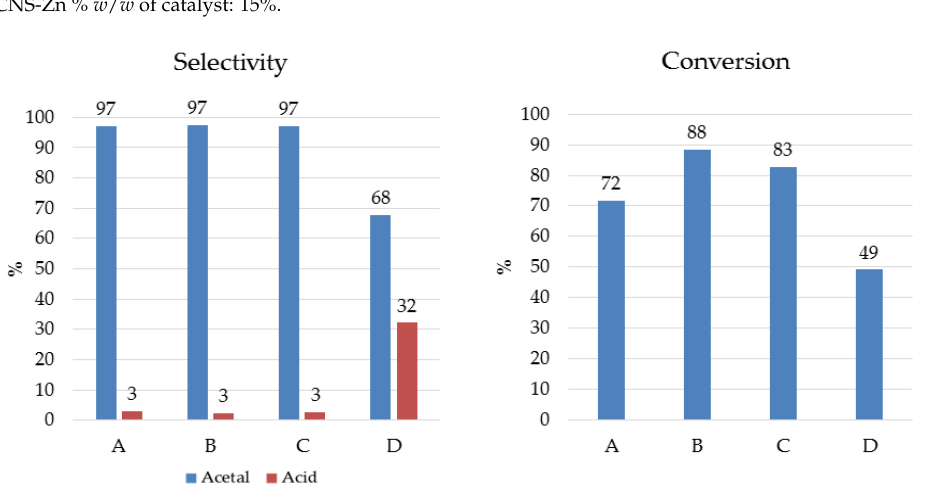
Figure 4. Schematic results for the reusability test with CNS-Cu.